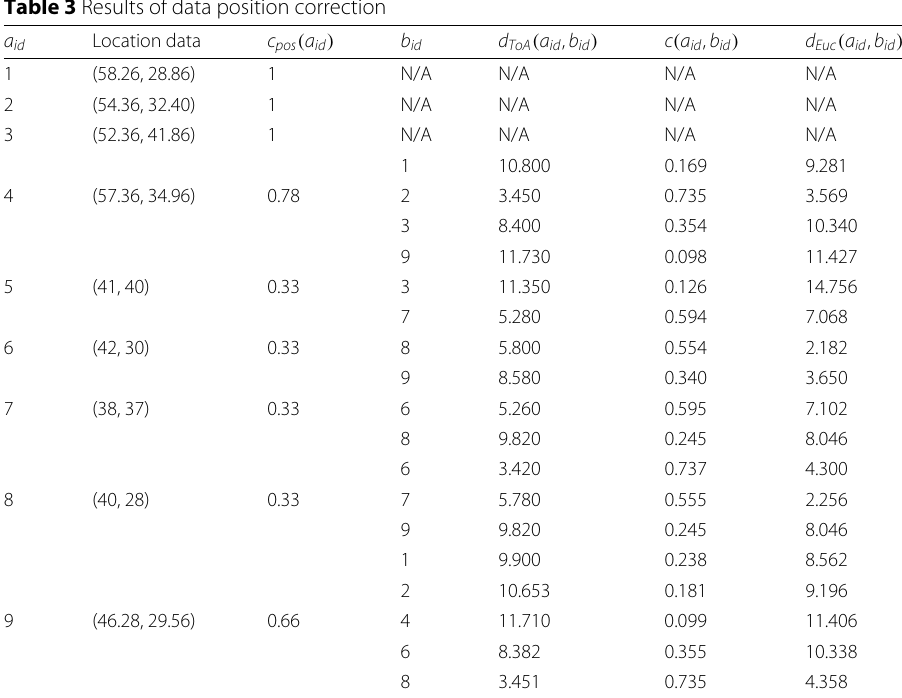
Table 3 Results of data position